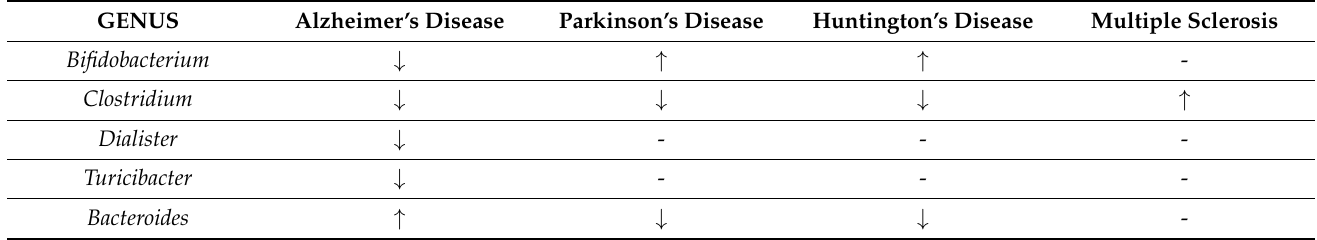
Figure 3. Variation in the composition of microbial diversity at the phylum level in numerous neurological disorders (AD, MS, PD, and HD). Changes in the occurrence of gut microbial population, dominant gut phyla, including Actinobacteria , Bacteroidetes , Firmicutes , Proteobacteria , Verrucomicrobia , and Fusobacteria, in neurological illnesses compared to in healthy controls. Table 1. Variation in the composition of microbial diversity at the genus level in numerous neurological disorders. Abundance or scarceness of specific genera in a particular neurological disease compared to in healthy controls, where ↑ represents higher in number compared to healthy ones, ↓ represents lower in number compared to healthy ones, and-represents not reported yet.